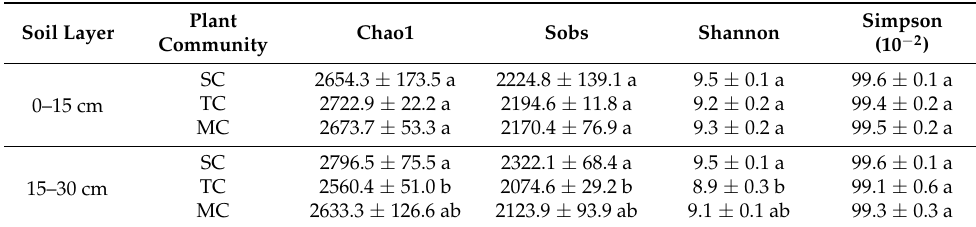
Table 1. The soil bacterial diversity indices (Chao1, Sobs, Shannon, Simpson) in different communi-